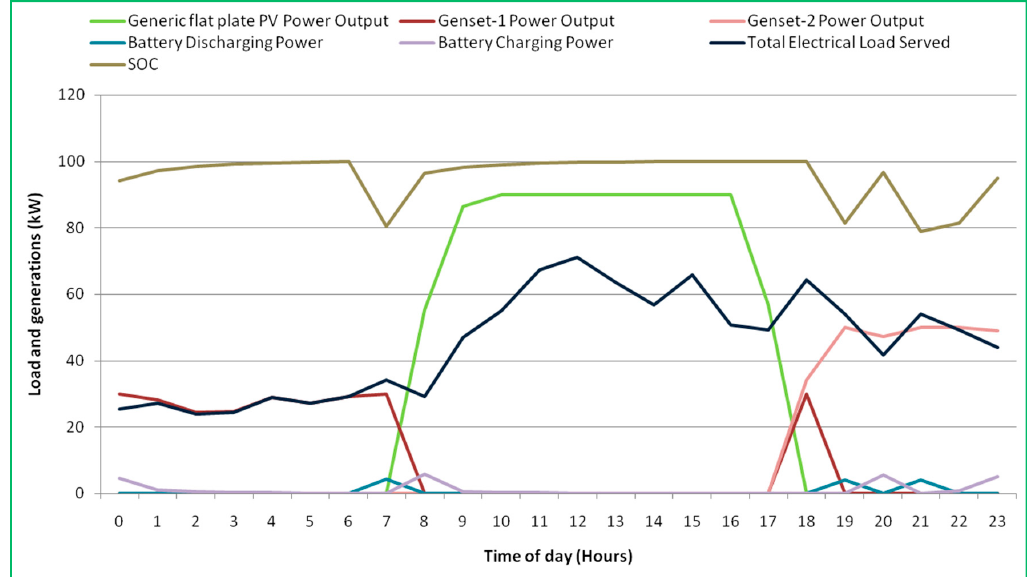
Figure 8. Load and generation on a random day of the dry season for the best combination of Case-1.